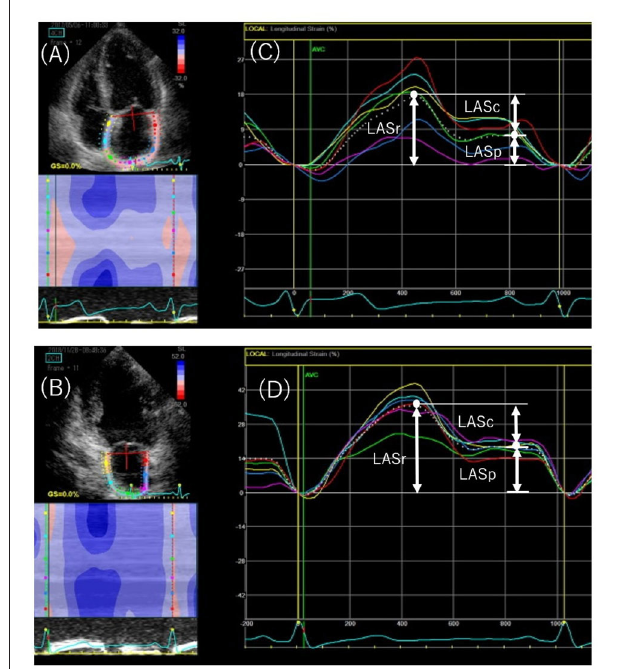
FIGURE 2 | Speckled-tracking echocardiography to assess left atrial (LA) phasic strain. Endocardial region of interest in the apical 4-chamber (A) and 2-chamber (B) views. The peak positive longitudinal strain (LASr) corresponds to LA reservoir function, and the strain during early and late diastole (LASc and LASp, respectively) corresponds to conduit and pump function in the apical 4-chamber (C) and 2-chamber (D) views. The white dotted curved line indicates the average of LA strain. LASr, peak left atrial strain during ventricular systole; LASc, peak left atrial strain during early diastole; LASp, peak left atrial strain during atrial